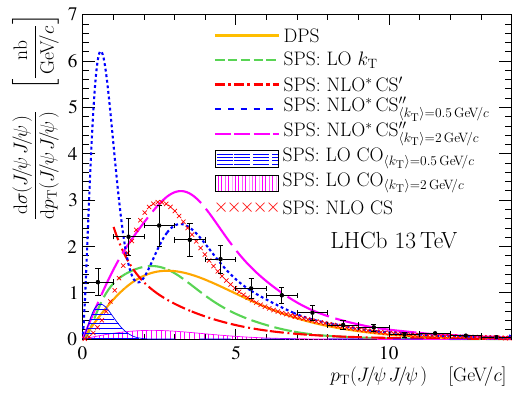
Figure 2. Comparisons between measurements and theoretical predictions for the di(cid:11)erential cross-sections as a function of p T ( J= J= ). The (black) points with error bars represent the mea-